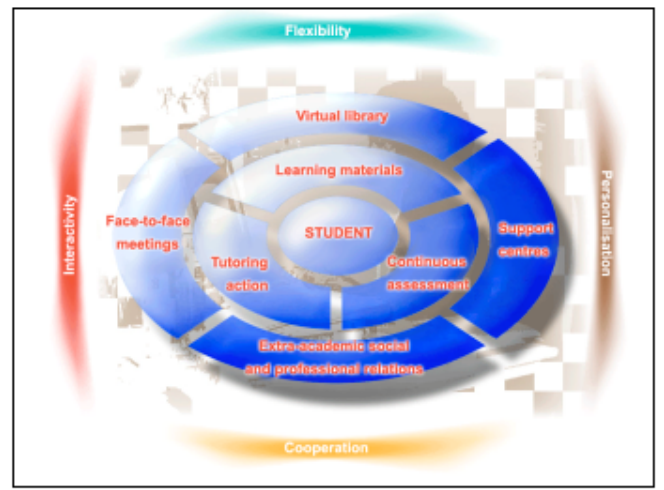
Figure 3. UOC’s Student Centred